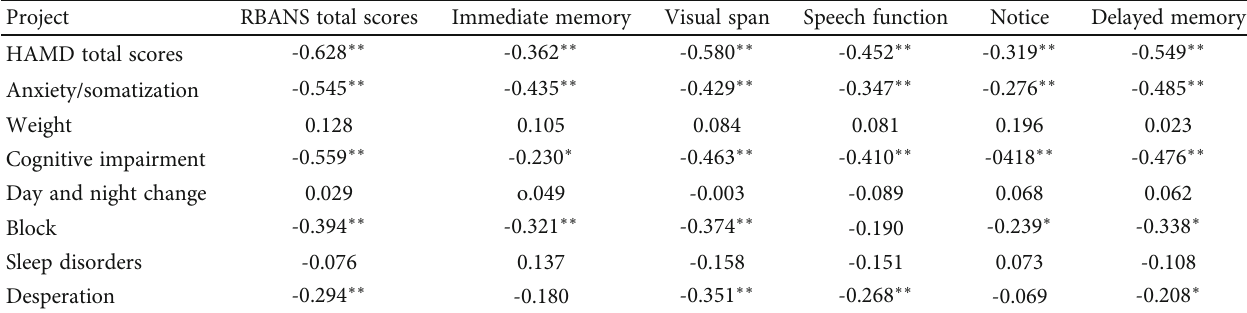
Table 7: Correlation analysis of depression and cognitive function in three groups after treatment.